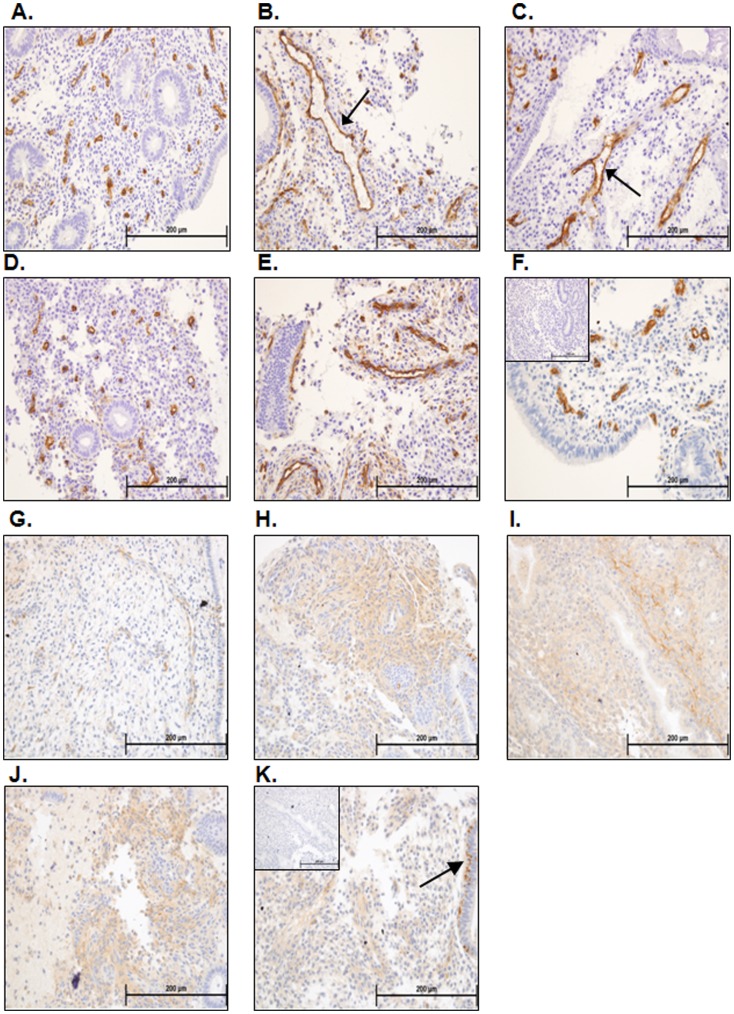
Vasculature/CD34 and decidualization/prolactin immunostaining.Blood vessels within the endometria of fertile women at LH+2 were generally small and compact (A). Examination of endometria from fertile women stimulated with the GnRH agonist protocol for ovum donation at hCG+2 revealed a mixture of small blood vessels and grossly enlarged blood vessels (B, arrow). Endometria from infertile women stimulated with the GnRH antagonist protocol at hCG+2 revealed a mixed picture of vascular development, with some endometria presenting grossly enlarged blood vessels (C, arrow) whereas some presented with small compact blood vessels (D). Women stimulated with the GnRH agonist protocol at hCG+2 who did not subsequently become pregnant presented with large endometrial blood vessels (E), whereas women stimulated with this protocol who did become pregnant generally presented with smaller more compact blood vessels (F). Fertile women at LH+2 had little to no immunostaining for prolactin within the endometrial stromal compartment (G). Some areas within the endometria of fertile women stimulated with the GnRH protocol for ovum donation (H), infertile women stimulated with the GnRH antagonist protocol (I) and infertile women stimulated with the GnRH agonist protocol who did not become pregnant (J) at hCG+2 demonstrated intense stromal prolactin immunostaining indicative of decidual changes. Endometria from infertile women stimulated with the GnRH agonist protocol at hCG+2 who subsequently became pregnant (K) demonstrated little stromal prolactin immunostaining, but did demonstrate glandular prolactin immunostaining indicative of secretory changes (K, arrows).